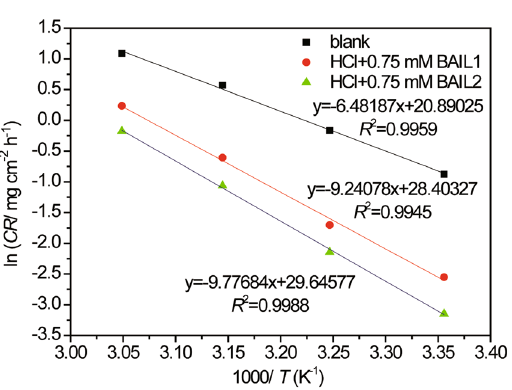
Figure 9. Arrhenius plot for carbon steel in 0.5 M HCl solution without BAIL ( ) and with 0.75 mM of BAIL1 ( ) and BAIL2 ( ).